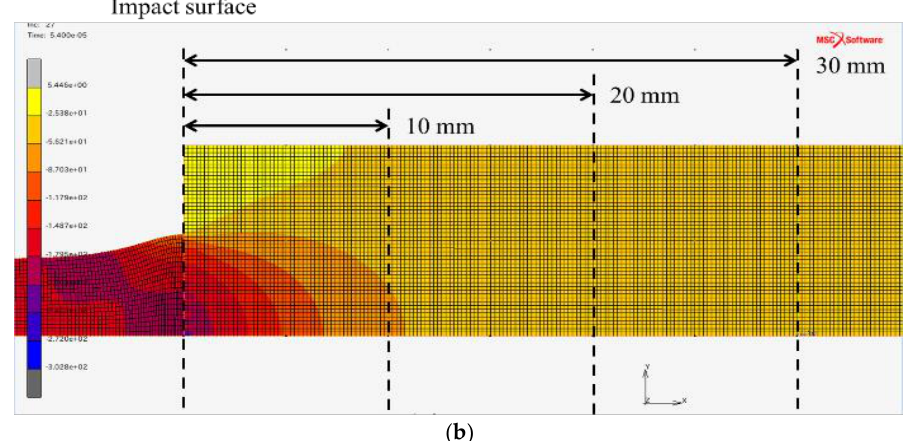
Figure 9. Determination of a measuring position of external force from the impact surface. ( a ) Time history of the external force. ( b ) Contour of axial stres s at 20 μs.